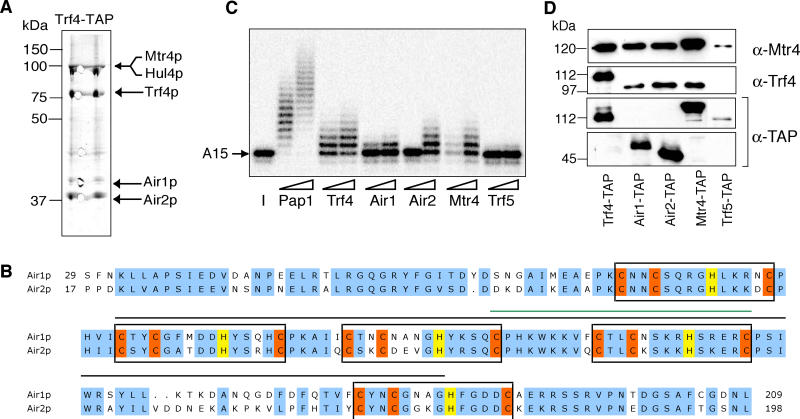
Characterization of the Trf4 Complex(A) Affinity purification of [His]6-tagged Trf4 complex identifies five associated polypeptides. Affinity-purified fractions were separated by SDS-PAGE on a 12% gel and stained with Colloidal Coomassie Blue. The protein bands indicated by arrows were identified by MS-MS sequencing. The round holes in the gel lane are a result of punching samples for MS-MS analysis.(B) Alignment of conserved regions of Air1p and Air2p. Boxes indicate five predicted CCHC-type zinc knuckle motifs. Lines above the sequences mark regions of interaction between Air1p (green) or Air2p (black) with Trf4p, as inferred from a yeast two-hybrid screen.(C) Polyadenylation activity associated with TAP-tagged versions of proteins identified as components of the Trf4 complex (Trf4, Mtr4, Air1, and Air2) and of Trf5. The 5′-end-labeled oligo(A15) was incubated with 5 or 10 ng of the affinity-purified extracts and analyzed by electrophoresis on a 15% gel. The position of the input RNA is indicated by an arrow. Protein was omitted in lane I. Recombinant yeast poly(A) polymerase (Pap1), 5 or 15 ng, was used as a positive control.(D) Trf4p and Mtr4p copurified with TAP-tagged proteins identified in the Trf4 complex. Western blot analysis of purified eluates with anti-Trf4p and anti-Mtr4p antibody and antibody against the calmodulin-binding region in the TAP-tag (α-TAP). The same amounts of protein complexes as used in the assay (C) were applied to the gel. The higher molecular weight of the Trf4p-TAP protein is due to the TAP-tag. All antibodies were used at a 1:2,000 dilution.